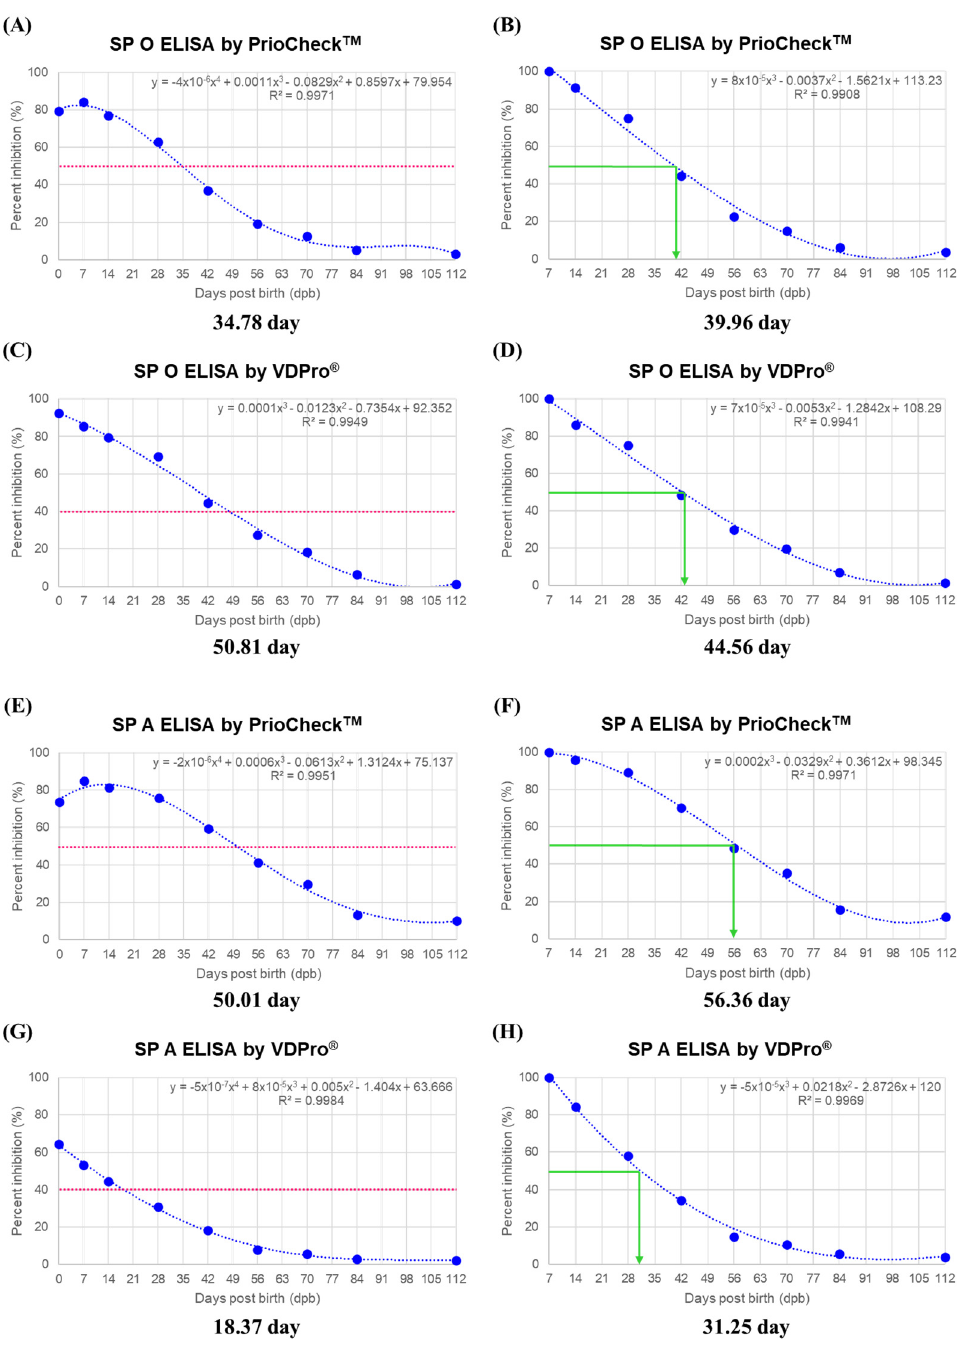
Figure 3. Time kinetics and half-life of maternally derived antibodies (MDA) as measured via SP O, A ELISA. To understand the properties of MDAs, five sows and 10 piglets from each sow were screened. For sows, blood was collected 7 days before farrowing. For piglets born to sows, blood was collected on 7, 14, 28, 42, 56, 84, and 112 days post-birth. Antibody titer in the sampled serum was measured via SP O, A ELISA using PrioCheck TM and VDPro ® kits. Data are presented in regression curves for time kinetics and half-life of MDAs. The red dotted line and the green solid line represent the threshold of antibody positive (+) or negative ( − ), and the half-life of MDAs, respectively. ( A – H ) represent: ( A , B ) Time kinetics and half-life of MDAs determined via SP O ELISA using the PrioCheck TM kit; ( C , D ) time kinetics and half-life of MDAs determined via SP O ELISA using the VDPro ® kit; ( E , F ) time kinetics and half-life of MDAs determined via SP A ELISA using the PrioCheck TM kit; ( G , H ) time kinetics and half-life of MDAs determined via SP A ELISA using the VDPro ® kit. The data represent the mean ± SEM of triplicate measurements (n = 5 for sows or 10